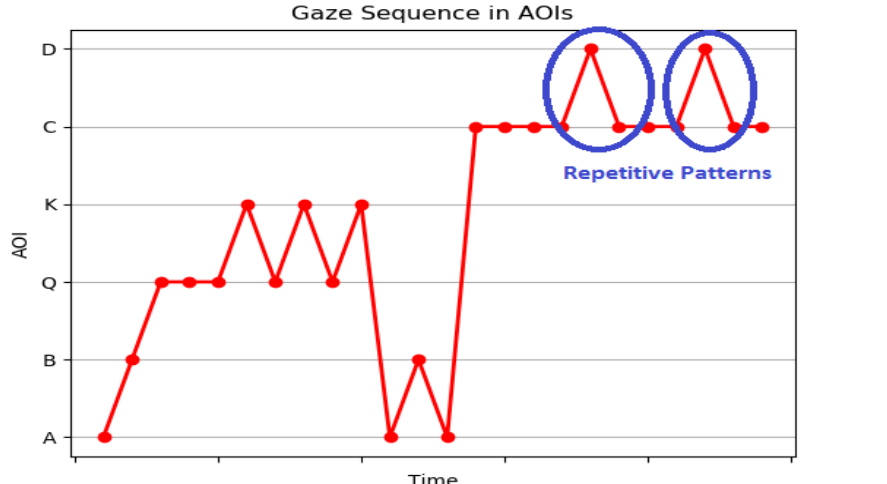
Figure 10. Gaze sequence plot representing WB of a performing learner where WB is observed between correct and incorrect